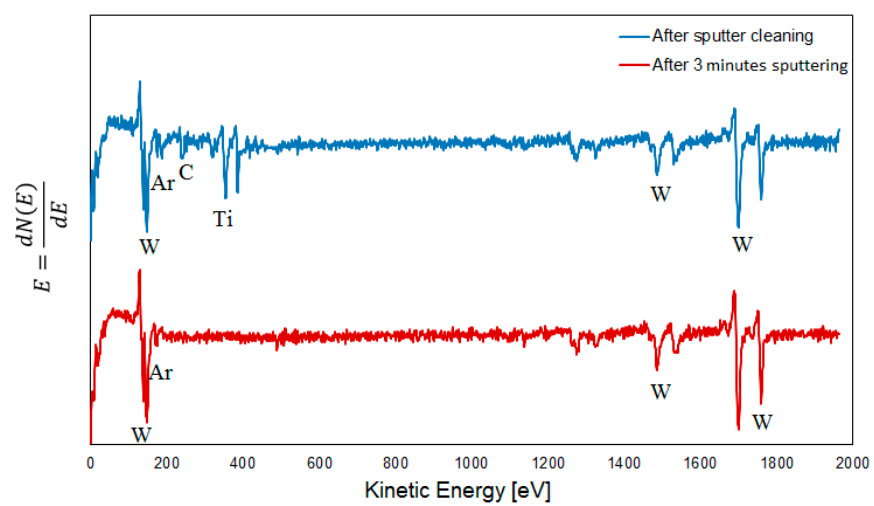
Figure 10. AES survey spectra obtained from area 4 after 5 s and 180 s sputtering. Note the presence of Ti (TiC) in the top surface.